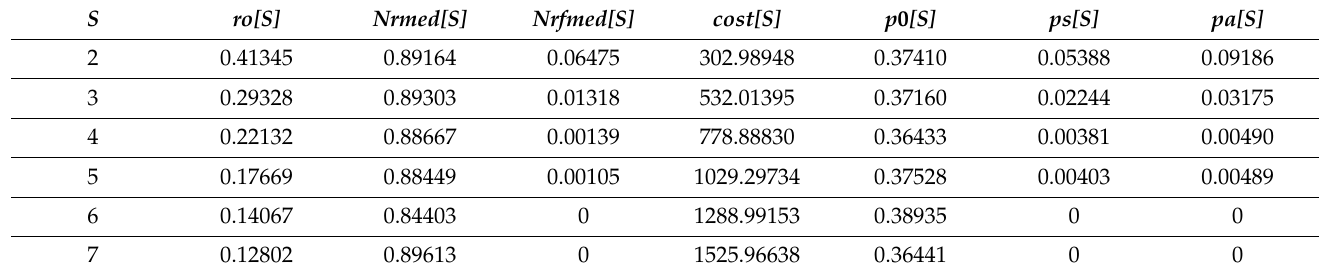
Table A5. Results for arrivals constant a = 1.5 and exponential services with u = 1.